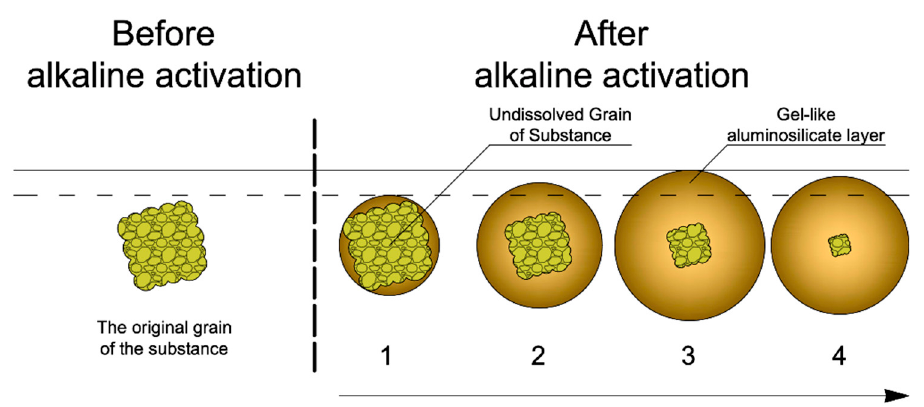
Figure 13. Phenomenological model of the formation of the system “gel layer–undissolved grain of material” in the process of alkaline activation.